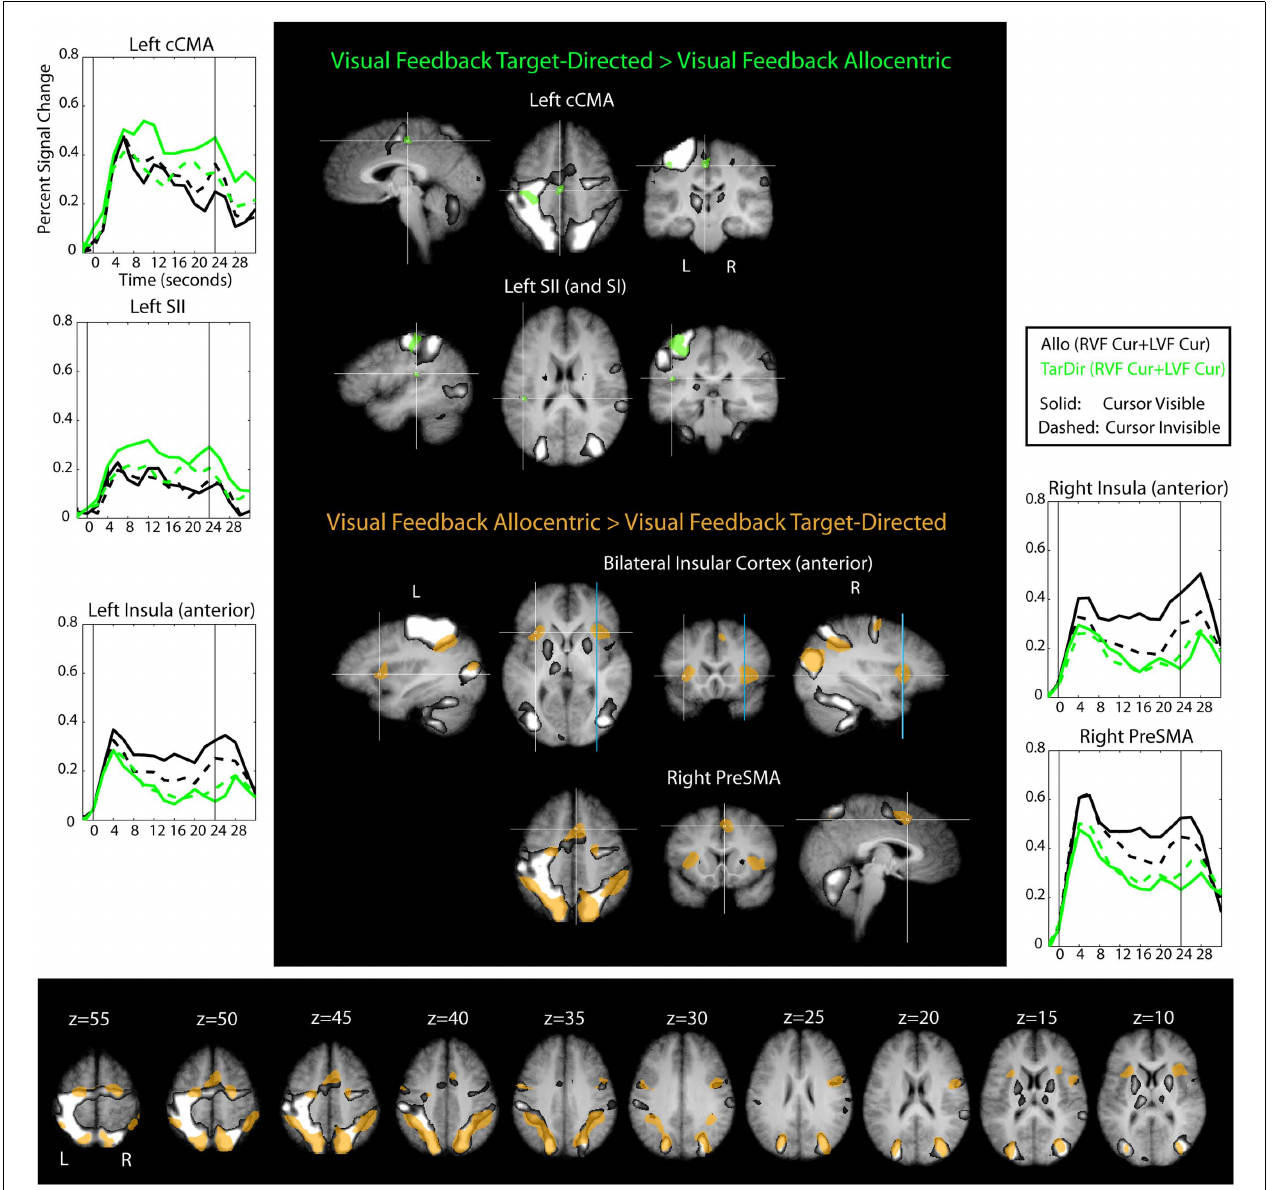
thresholds. Upper panel: brain areas that are more active during target-directed or allocentric visual feedback conditions are denoted in green and brown, respectively. Also shown is the “shared sensory–motor network” (gray) and time courses of areas denoted in green and brown that do not overlap with the “shared sensory–motor network.” For stereotactic coordinates of activation foci see Table 3 . Lower panel: slice views to illustrate extent of “allocentric visual feedback areas” (brown) and relative arrangement with respect to the “hared sensory–motor network”